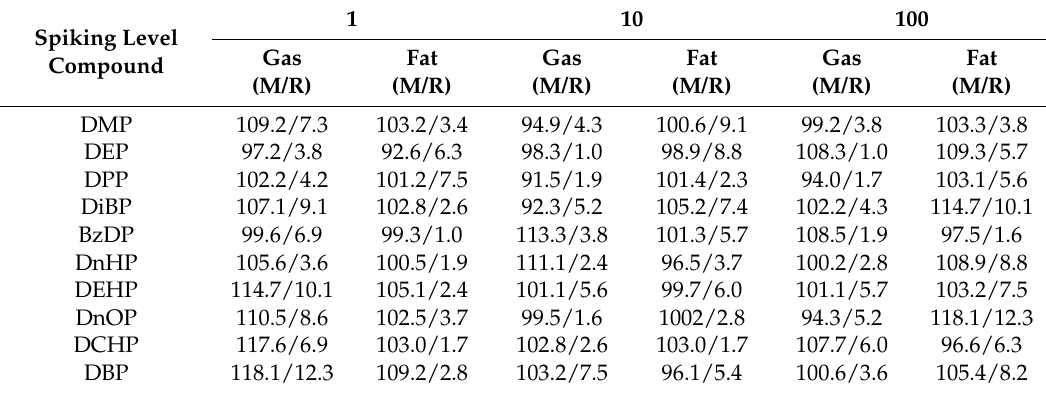
Table 6. Trueness results for 10 phthalate compounds in non-alcoholic beverages matrices. Spiking